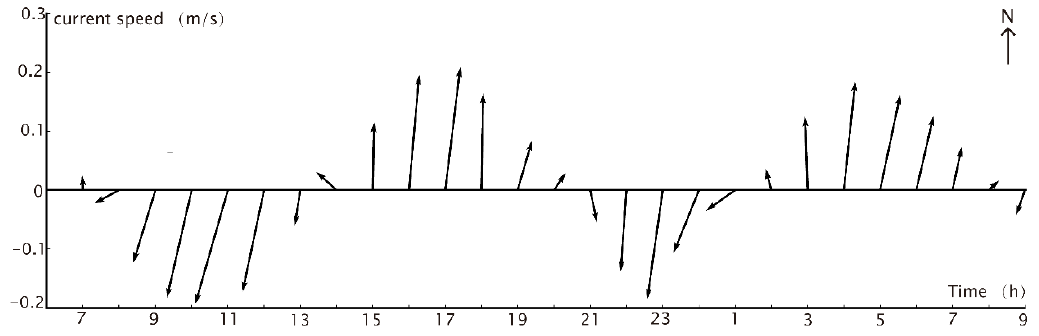
Figure 2. Tidal velocity and direction during a tidal cycle during on10–11 March 2012 (The length of the arrow refers to the velocity of the currents and the direction measured counterclockwise from the east, the north is 90 ◦